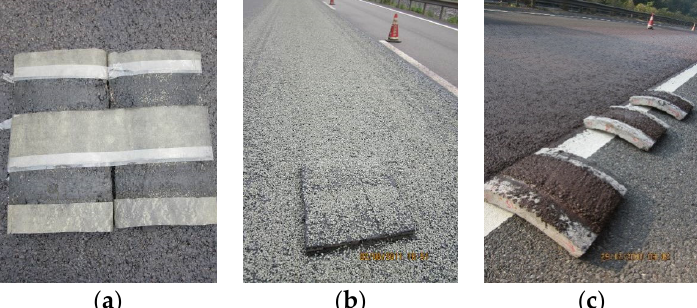
Figure 5. Functional layer specimens prepared on site: ( a ) fog seal specimen, ( b ) chip seal specimen, and ( c ) micro-surfacing specimen.